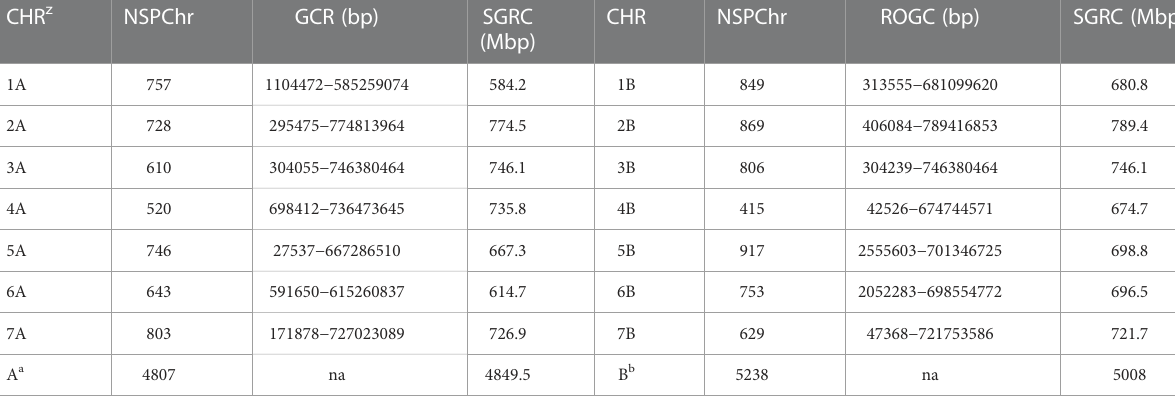
TABLE 2 The distribution of the 10,045 SNP markers across the entire durum wheat genome.